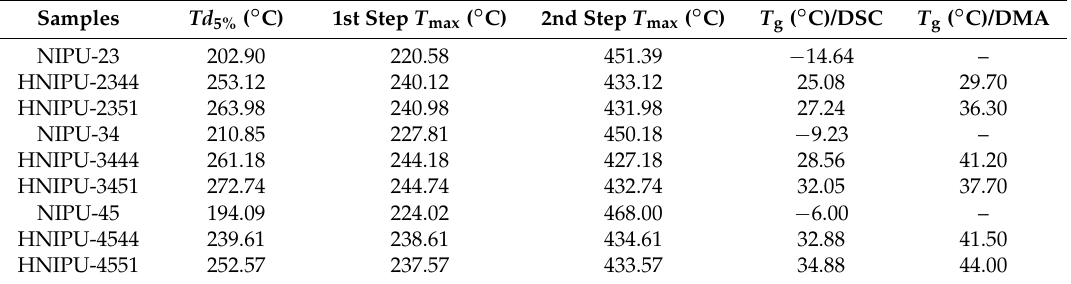
Figure 2. Differential scanning calorimetry (DSC) cures of the different HNIPUs. Table 2. Thermal properties of the different nonisocyanate polyurethanes (NIPUs) and HNIPUs.